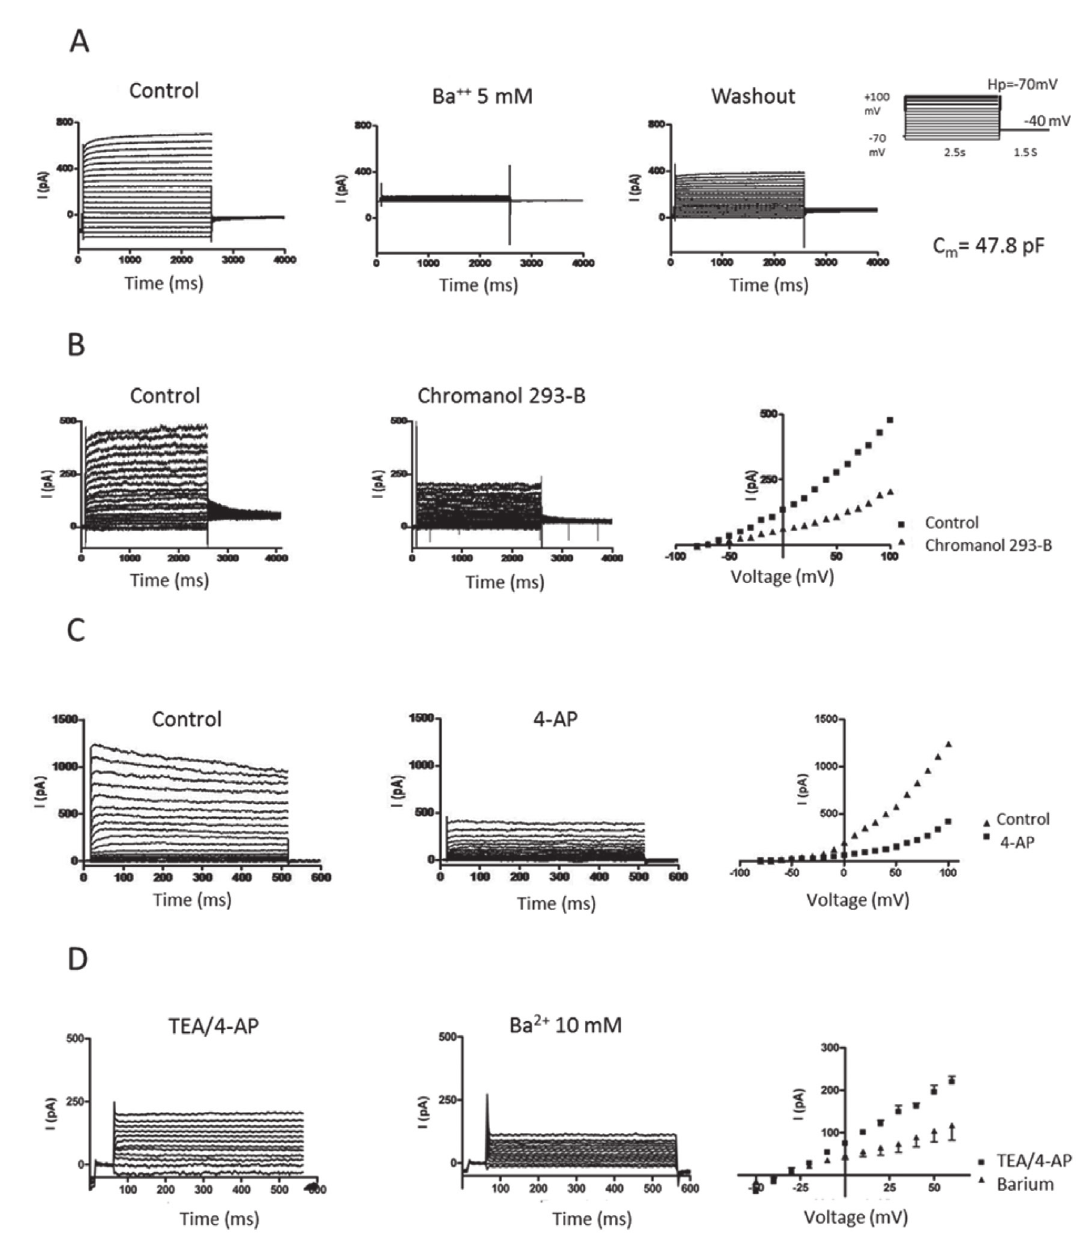
Figure 3 - Voltage-activated currents. A: whole cell voltage activated currents recorded in modified Tyrode’s solution (left). Blocking effect of Barium 5 mM (middle) on outward rectifying currents is reversible after washout (right) (n=14); B: effect of Chromanol 293- B on outward rectifying currents blocker. Family of currents recorded on a cell bathed in modified Tyrode’s solution without or with Chromanol 293-B (left and middle). Right shows current-voltage relationship (I-V) in absence ( ) or presence of Chromanol 293-B (▲); C: effect of 4-AP (5 mM) on fast inactivating outward currents. Family of currents recorded on a cell bathed in modified Tyrode’s solution without (left) or with 4-AP (middle). Right figure shows current-voltage relationship (I-V) in absence (▲) or presence of 4-AP ( ). Currents were elicited by depolarizing steps from Vh = −70 mV to potentials ranging from −80 mV to +100 mV; D: voltage- activated barium currents were recorded on a cell bathed in modified Tyrode’s solution contained TEA (10 mM) and 4-AP (5 mM) without (left) or with 10 mM BaCl (middle). Right figure shows current-voltage relationship in absence ( ) or presence of BaCl (▲). 2 2 Cells were maintained at a holding potential of −70 mV and stepped from −60 mV to +60 mV in 10 mV increments for 500